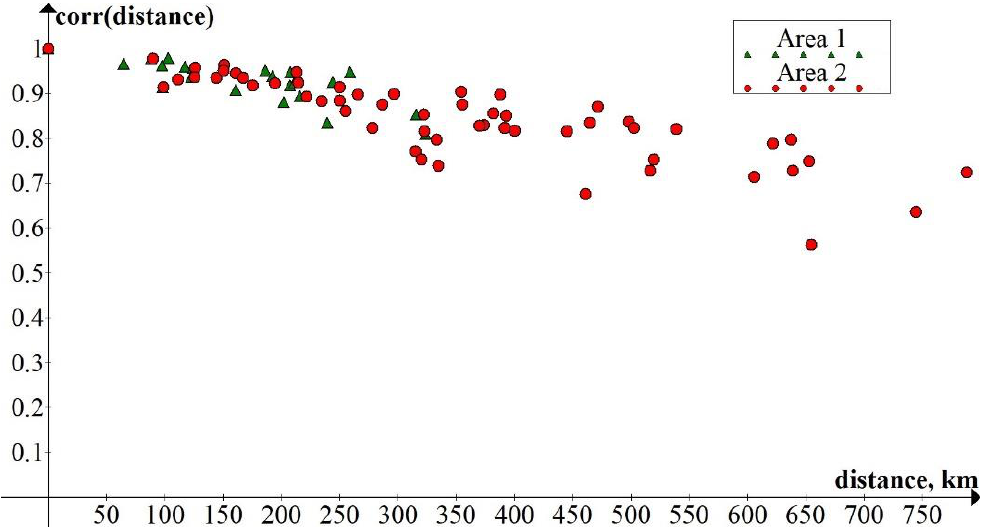
Figure 3. Correlation coefficients of the average daily WCI as a function of distance, 16 January.